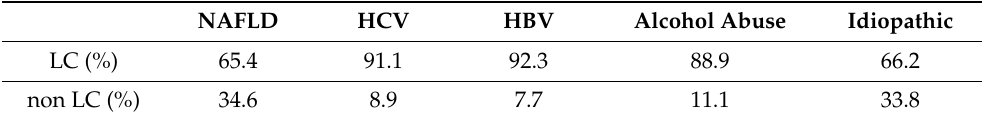
Table 1. Presence of liver cirrhosis at the procarcinogens. NAFLD